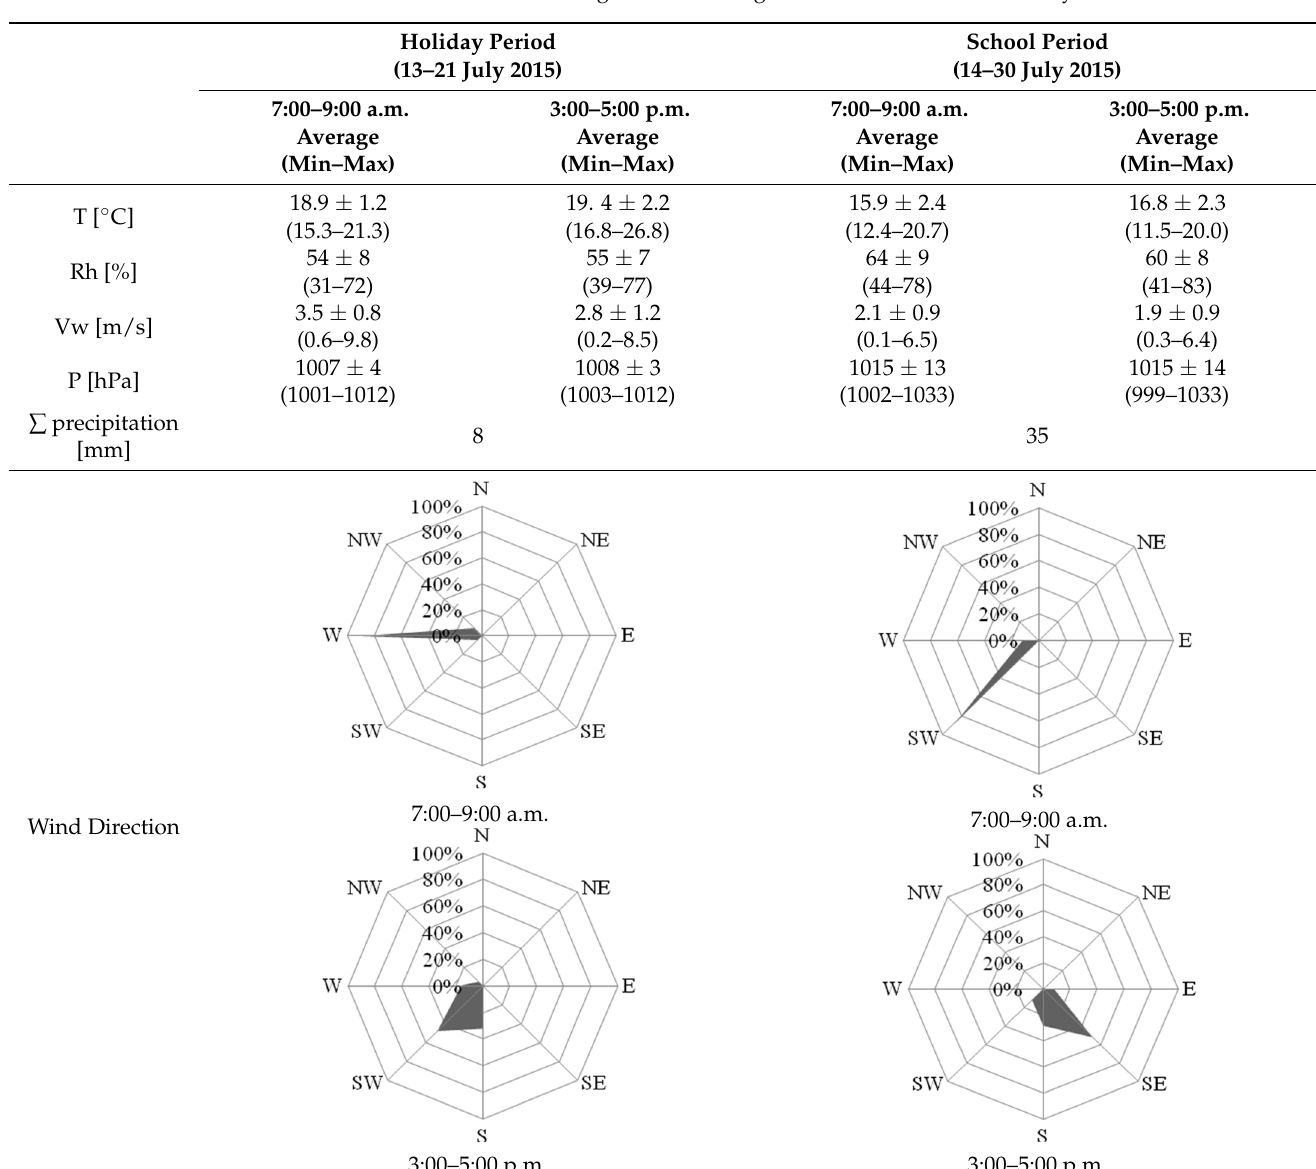
Table 1. Statistical characteristics of meteorological data during the research conducted in Gdynia in